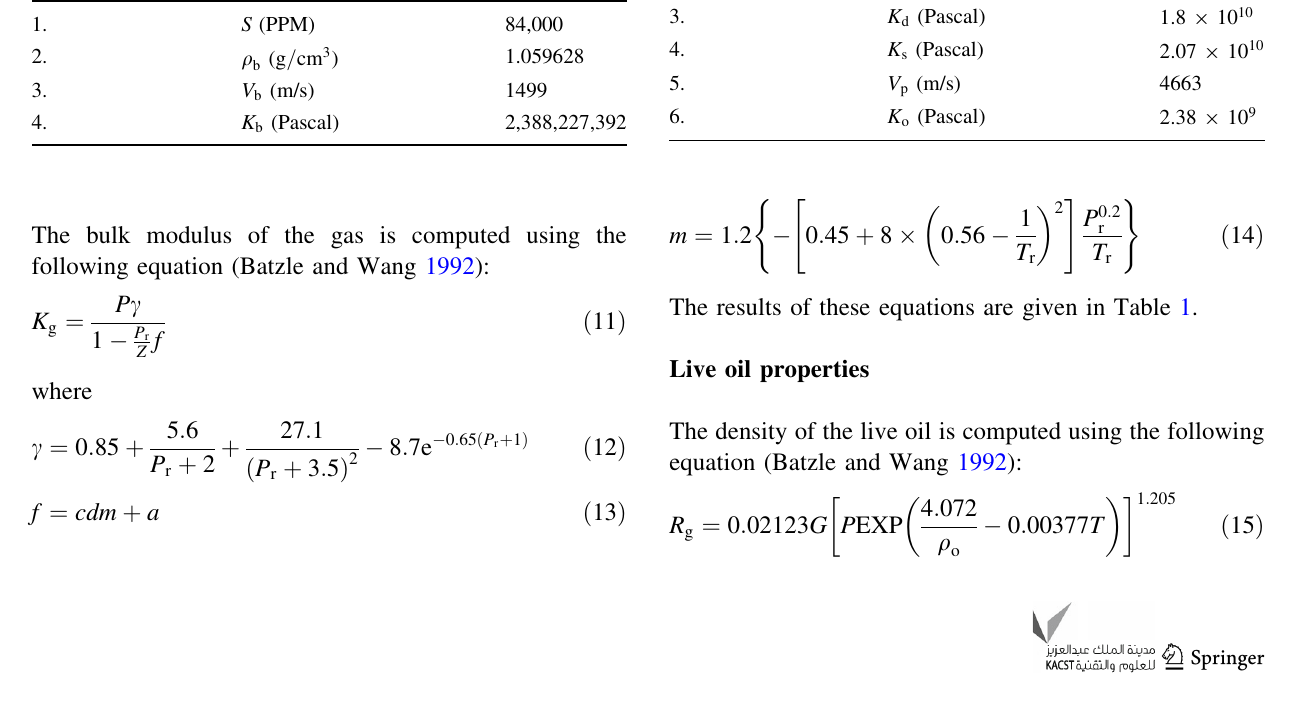
Table 3 Computed properties of brine water S/no.